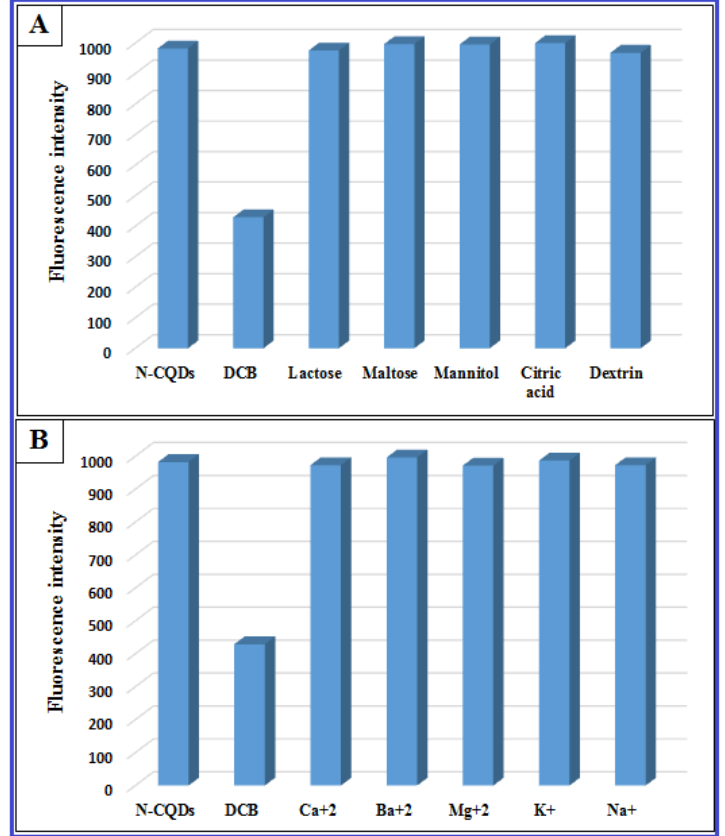
Figure 7. ( A ) The response of possible interfering excipients; ( B ) the selectivity of N-CQDs towards DCB in the presence of different metal ions.